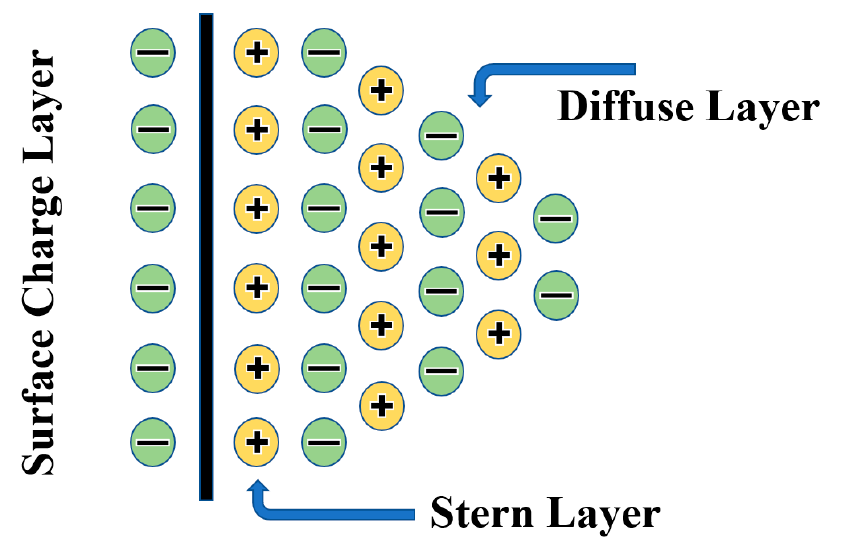
Figure 5. Formation of electrical double layer (EDL)